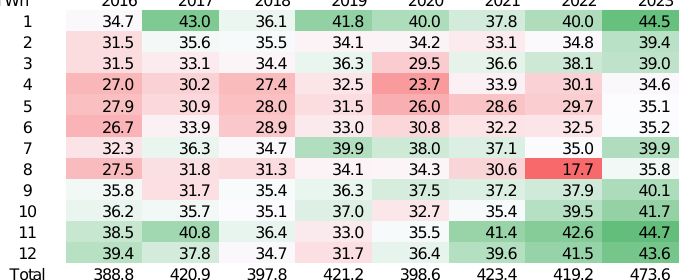
Figure 8. Positive forecast of natural gas supply to Italian end users for 2024. Forecast exercised for the period September 2022 to December 2023. These data can be found here: https://www.ec.europa.eu/ (accessed on 20 March 2022).